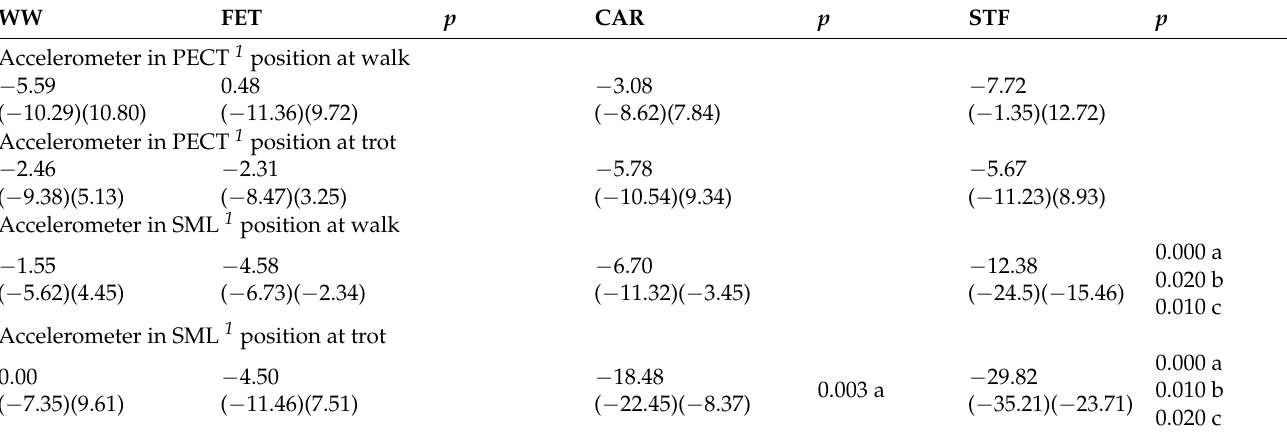
Table 3. Median and quartiles of the percent of change from baseline of the stride symmetry, mea- sured on a track, at four different water depths, at walk and at trot and with the accelerometer fixed in two different positions. WW: treadmill without water; FET: water at the level of the fetlock;